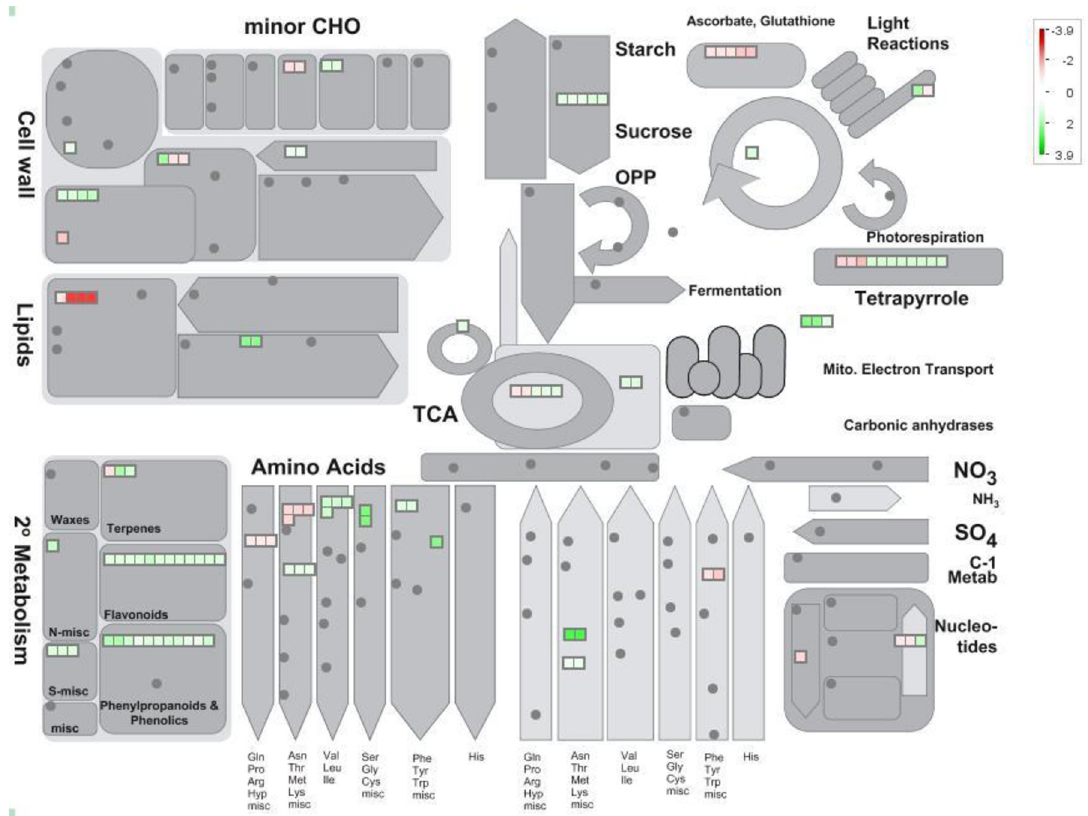
Fig 5. Metabolism overview in teosinte line Ames 21812 visualized by Mapman. Squares in red (down-regulated) or green (up- regulated) indicate individual DEGs categorized as shown.